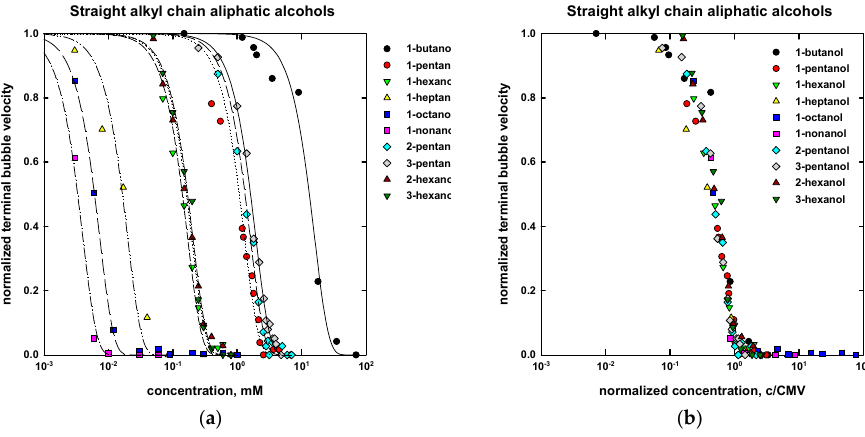
Figure 5. Influence of straight alkyl chain aliphatic alcohols concentration expressed in mM ( a ) and normalized surfactant concentration ( c /CMV) ( b ) on the normalized terminal bubble velocity.